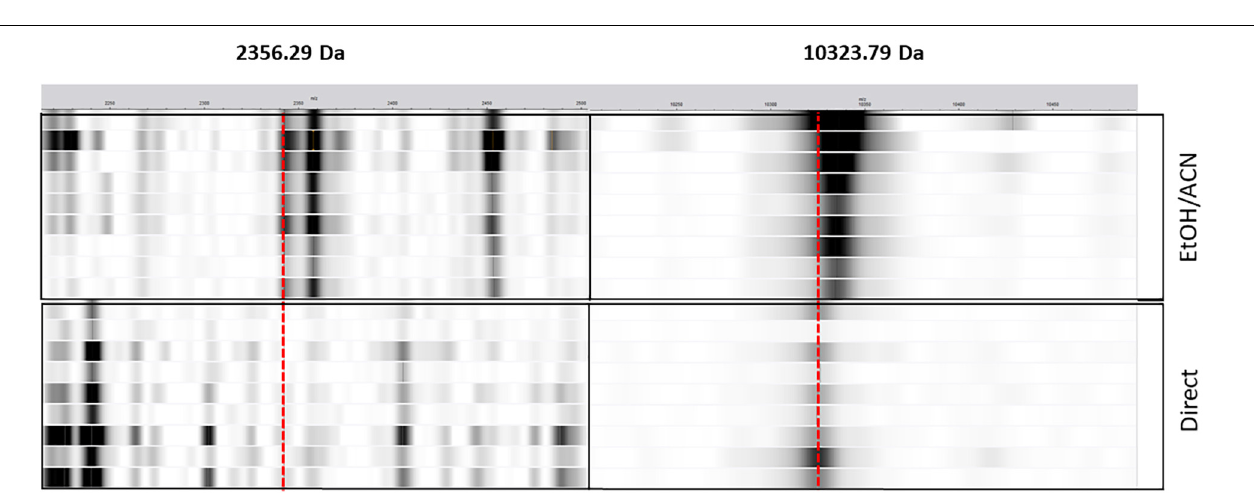
FIGURE 5 | Comparison of precision-recall curves for the three-extraction tested on (A) C. jejuni ( n = 68 MSPs) and (B) C. coli ( n = 35 MSPs) of the test set (30%). EtOH/ACN: complete ethanol/acetonitrile-based proteins extraction. RF, Random Forest algorithm; LR, Logistic Regression algorithm; NB, Nave Bayes algorithm.